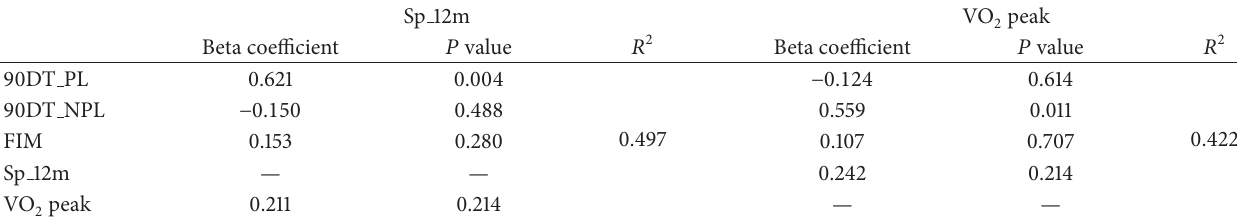
Table 4: Linear regression model for walking velocity and VO